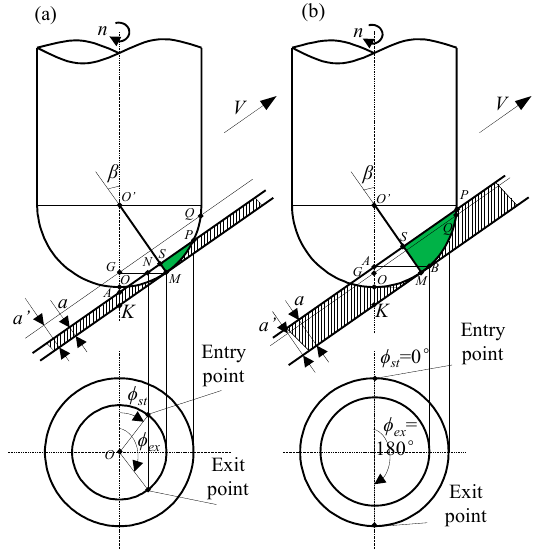
Figure 4. Cutting axis titled to the workpiece surface: ( a ) axial cutting depth a ≤ a’; ( b ) axial cutting depth a > a’.